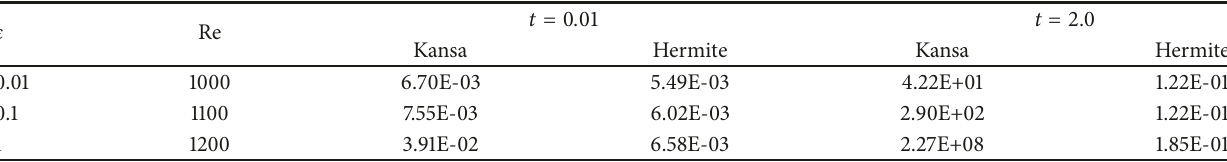
Table 8: Averaged 𝐿 𝑟𝑚𝑠 - error obtained with 𝑁 = 100 , Δ𝑡 = 0.001 for high Reynolds number.